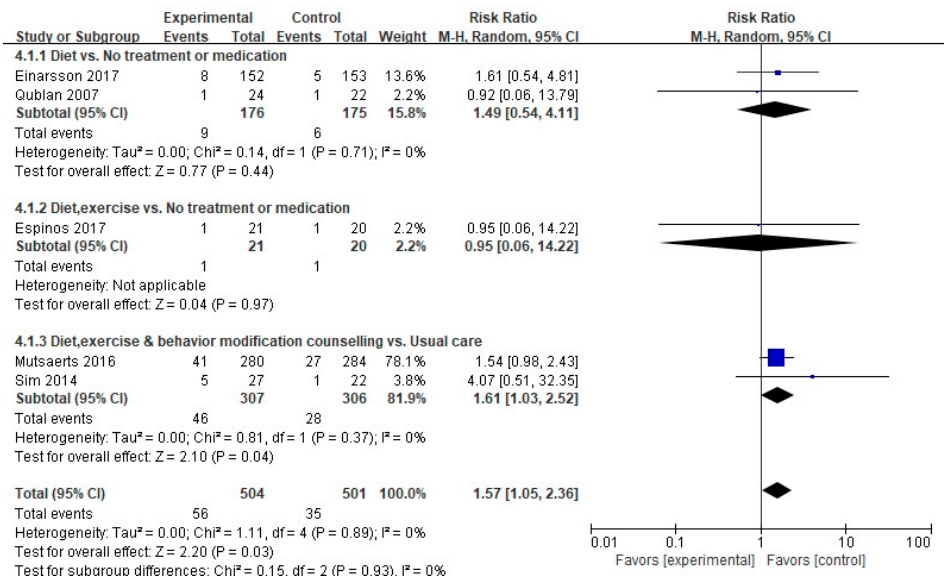
Figure 7. Forest plot of nonpharmacological interventions on the miscarriage rate. M-H, the Mantel- Figure 7. Forestplotofnonpharmacologicalinterventionsonthemiscarriagerate. M-H,theMantel-Haenszel Haenszel method; Random, random effects model; CI, confidence interval. method; Random, random effects model; CI, confidence interval.